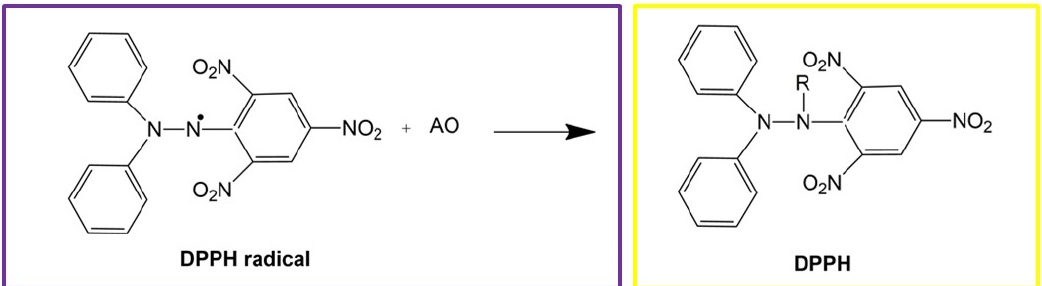
Figure 3. DPPH. Free radical reaction with an antioxidant (AO).